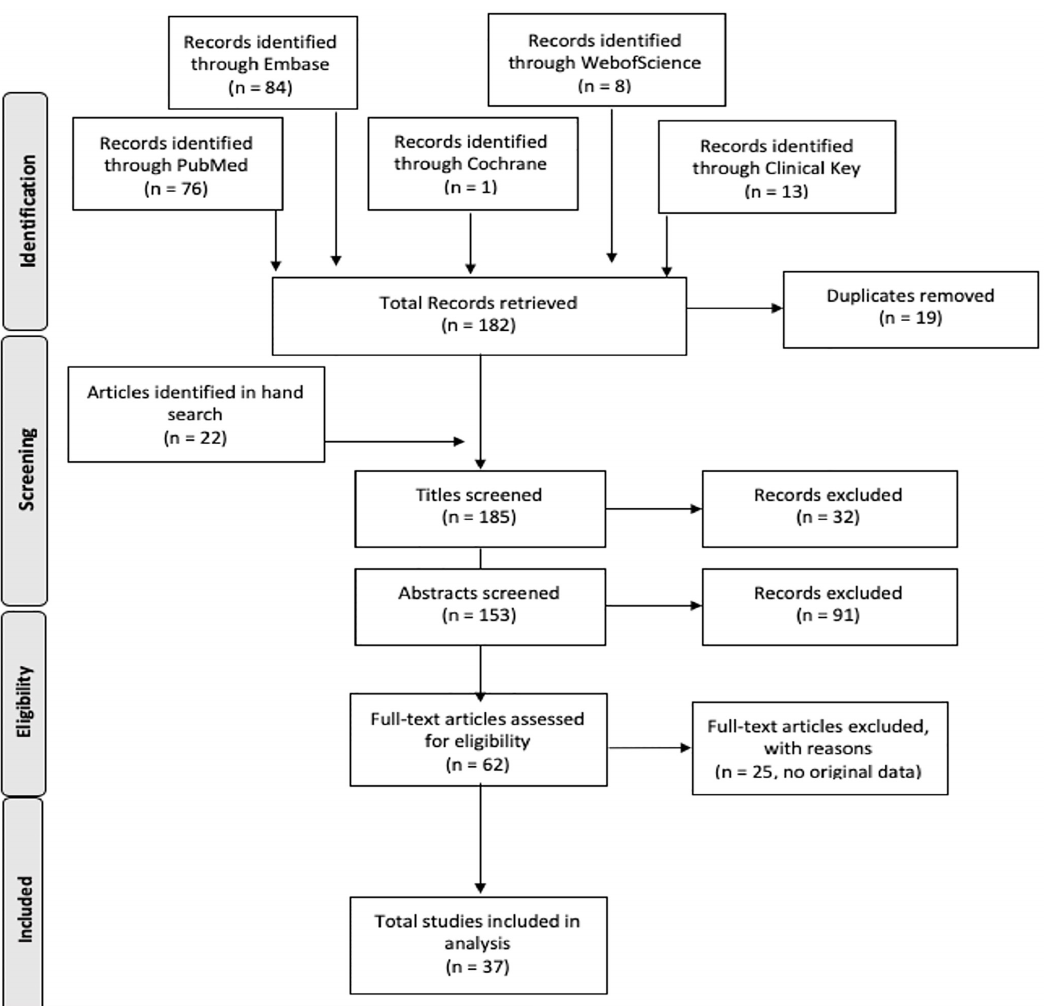
Figure. Process of systematic searches using combinations of “physician,” “wellness,” “wellbeing,” “stress,” “burnout,” “COVID-19,” and “SARS-CoV-2” to provide a scoping review on publications measuring the effects of novel coronavirus 2019 on wellness of healthcare